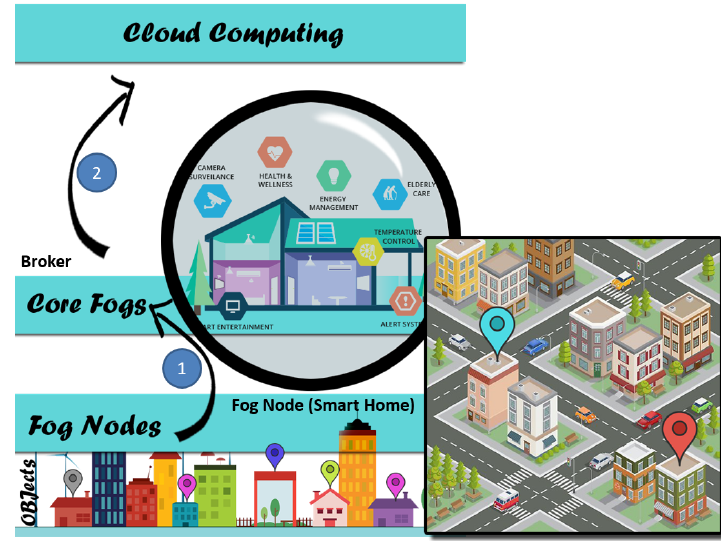
Figure 24. Blind Approach with Smart Home System.